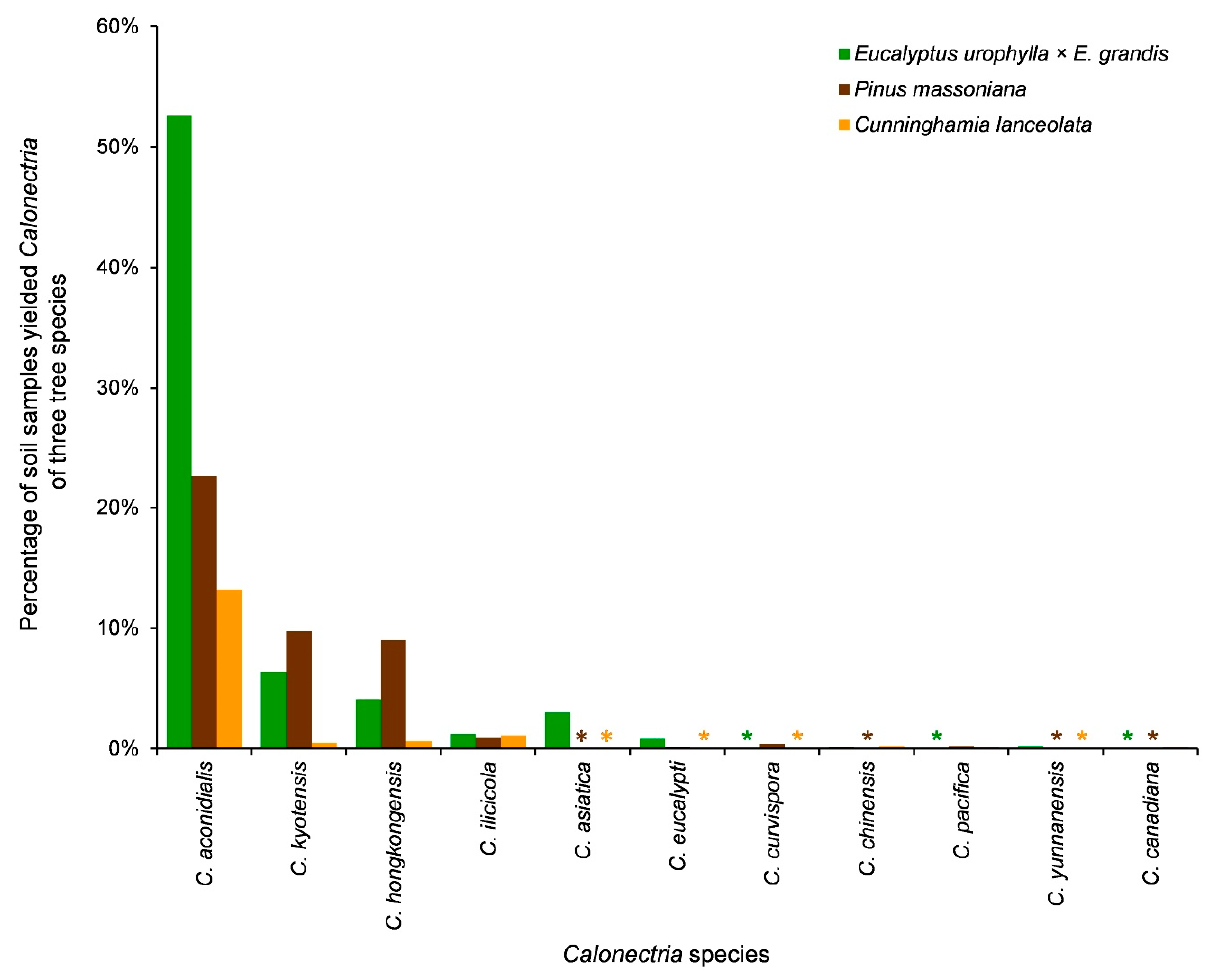
Figure 7. The percentage of soil samples that yielded each of the 12 Calonectria species from the plantations of the three tree species. “*” means zero.